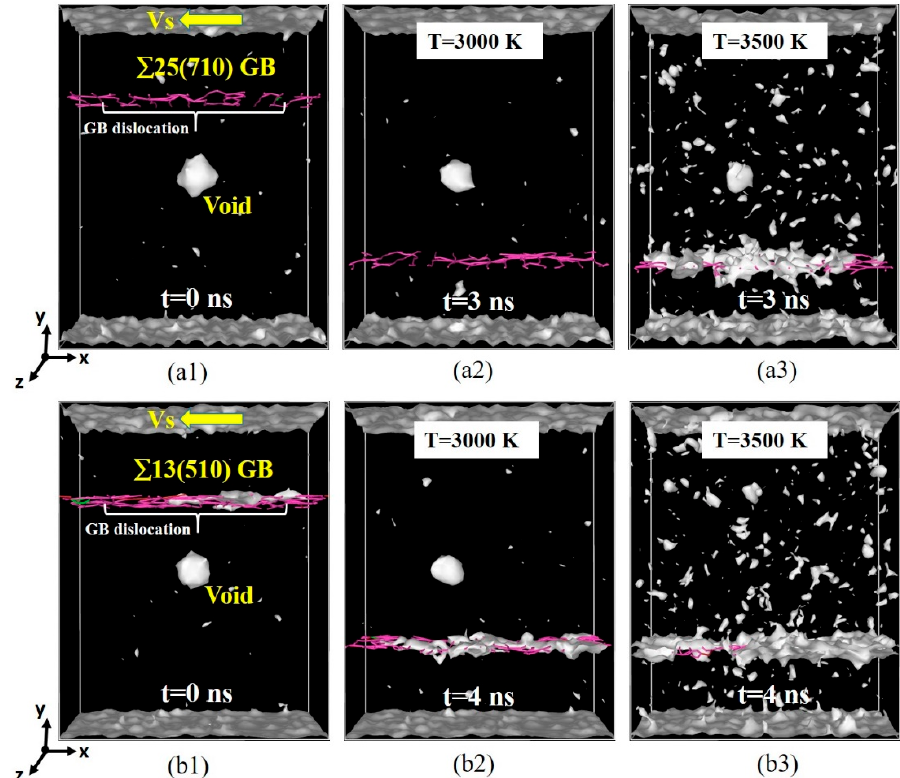
Figure 5. Snapshots of the interaction between GB and a void at 3000 K and 3500 K. ( a1 – a3 ) Σ 25(710) GB, ( b1 – b3 ) Σ 13(510) GB. The extracted profile of GB and void was presented using the dislocation extraction algorithm. The dynamic process of GB-void interaction at 3000 K is shown in Supplementary Videos S3 and S4.